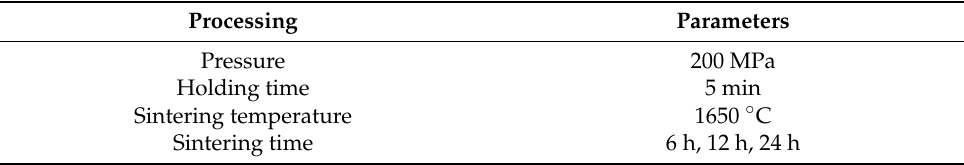
Table 2. Isostatic pressing and high temperature sintering